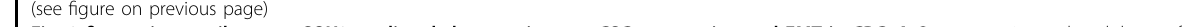
Fig. 2 β -catenin contributes to SOX2-mediated chemoresistance, CSCs properties, and EMT in CRC. A Overexpression or knockdown of β -catenin was conducted in SW480 and SW620 cells transfected with SOX2 clone or SOX2 shRNA, then immunoblot was performed with indicated antibodies. B – F The ability of chemoresistance ( B ), proliferation ( C ), stemness ( D ), migration ( E ), and invasion ( F ) in SW480 cells co-transfected with SOX2 clone and β -catenin siRNA was assessed by drug sensitivity assay, cell viability assay, tumor sphere formation assay, wound healing assay and transwell invasion assay. G β -catenin is a potential binding partner of SOX2 predicted by the STRING database. H Immuno fl uorescence was performed to analyze the co-localization of SOX2 and β -catenin in SW480 and SW620 cells. I co-IP assay was used to analyze the interaction between SOX2 and β -catenin in both cytoplasm and a nuclear fraction of SW480 and SW620 cells. J Western blot detected the expression of SOX2 and β -catenin in the nucleus and cytoplasm of SOX2-overexpressing SW480 cells and SOX2-silencing SW620 cells. K TOP/FOP Flash reporter assay was used to detected β -catenin transcriptional activity in SW480 and SW620 cells transfected with SOX2 clone or SOX2 shRNA. L , M Total expression of β -catenin and its target genes (c-Myc, cyclin D1, and Axin2) was detected by qRT-PCR ( L ) and western blot ( M ) in SOX2-overexpressing SW480 cells and SOX2-silencing SW620 cells. N Effect of β -catenin overexpression or knockdown on SOX2 expression was detected by western blot in SW480 and SW620 cells. O Effect of β -catenin overexpression or knockdown on SOX2-mediated ABCC2 promoter transactivation was assessed in HEK293T cells by luciferase reporter assay. Experiments were conducted in triplicate. Data are shown as mean ± SEM. * P < 0.05, ** P < 0.01, and *** P <